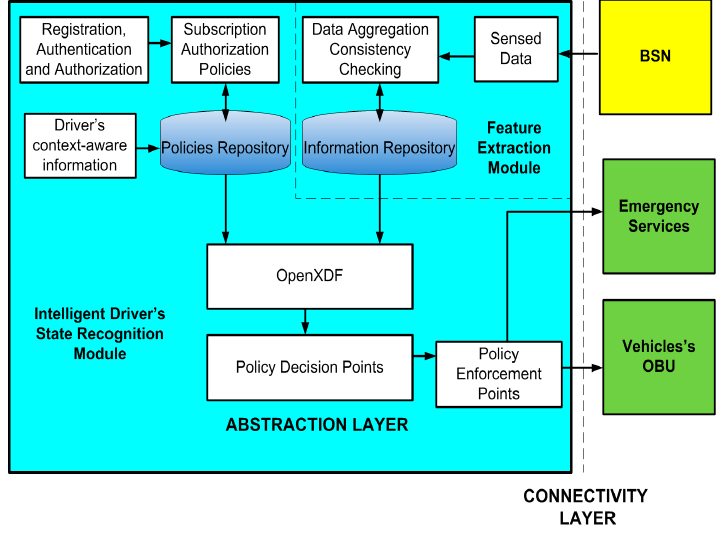
Figure 3. Monitoring Station Architecture.